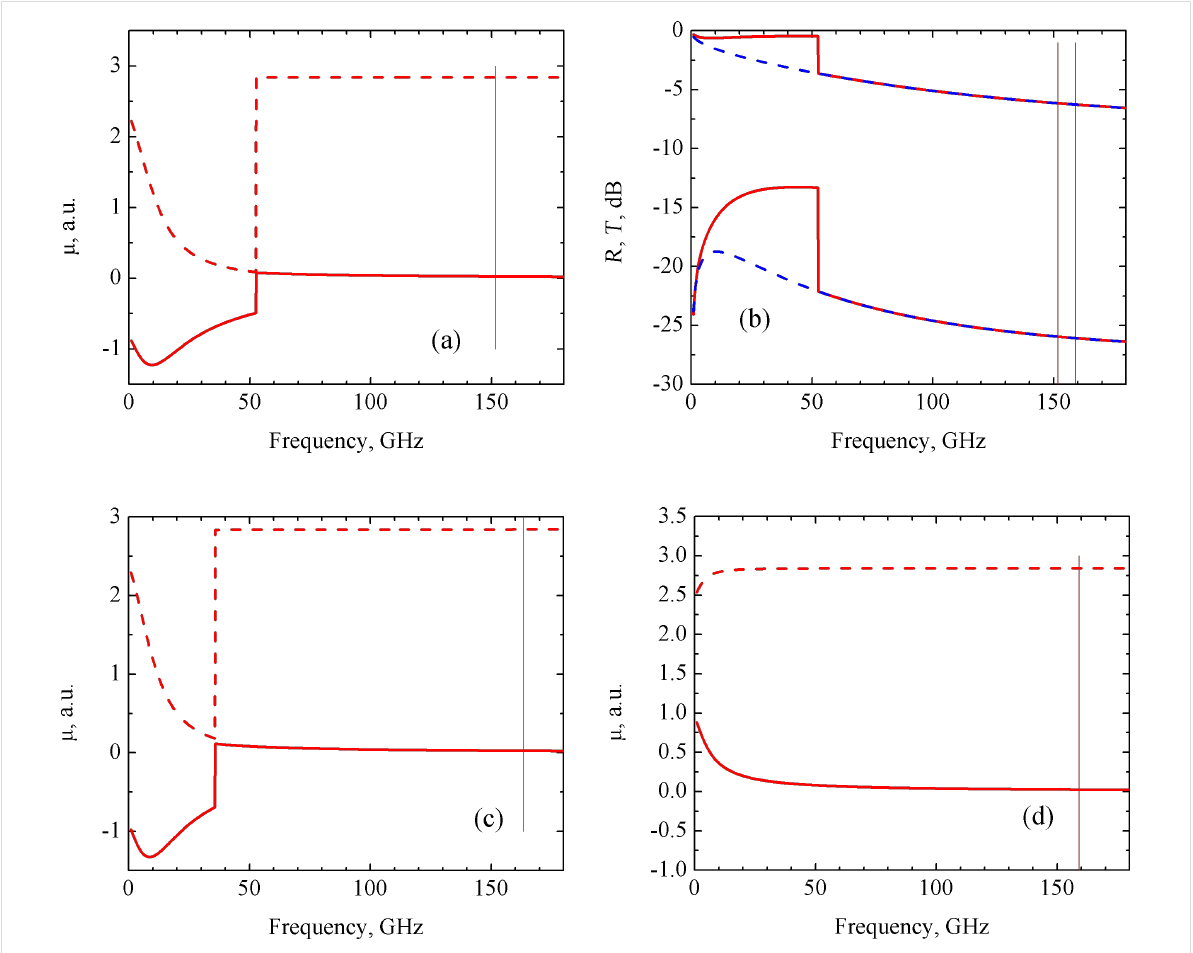
Figure 4: Frequency dependence of the real (dashed lines) and imaginary (solid lines) parts of the permeability (a,c,d), and of the reflection R (upper curves) and transmission T (lower curves) coefficients (b) of the CNT-based nanocomposite consisting of a fully parallel circuit. (a) R i = 0.01 Ω , L i = 0.09 pH, C i = 10 pF ( ω 0 = 151.7 GHz); (b) R i = 0.01 Ω , L i = 0.09 pH, C i = 10 pF ( ω 0 = 151.7 GHz) (solid red lines) and R i = 0.01 Ω , L i = 0.1 pH, C i = 10 pF ( ω 0 = 159.2 GHz) (dashed blue lines); (c) R i = 0.01 Ω , L i = 0.095 pH, C i = 10 pF ( ω 0 = 163.3 GHz); (d) R i = 0.01 Ω , L i = 0.1 pH, C i = 10 pF ( ω 0 = 159.2 GHz). The resonance frequencies of the R i L i C i circuits, ω 0 , are represented by the vertical